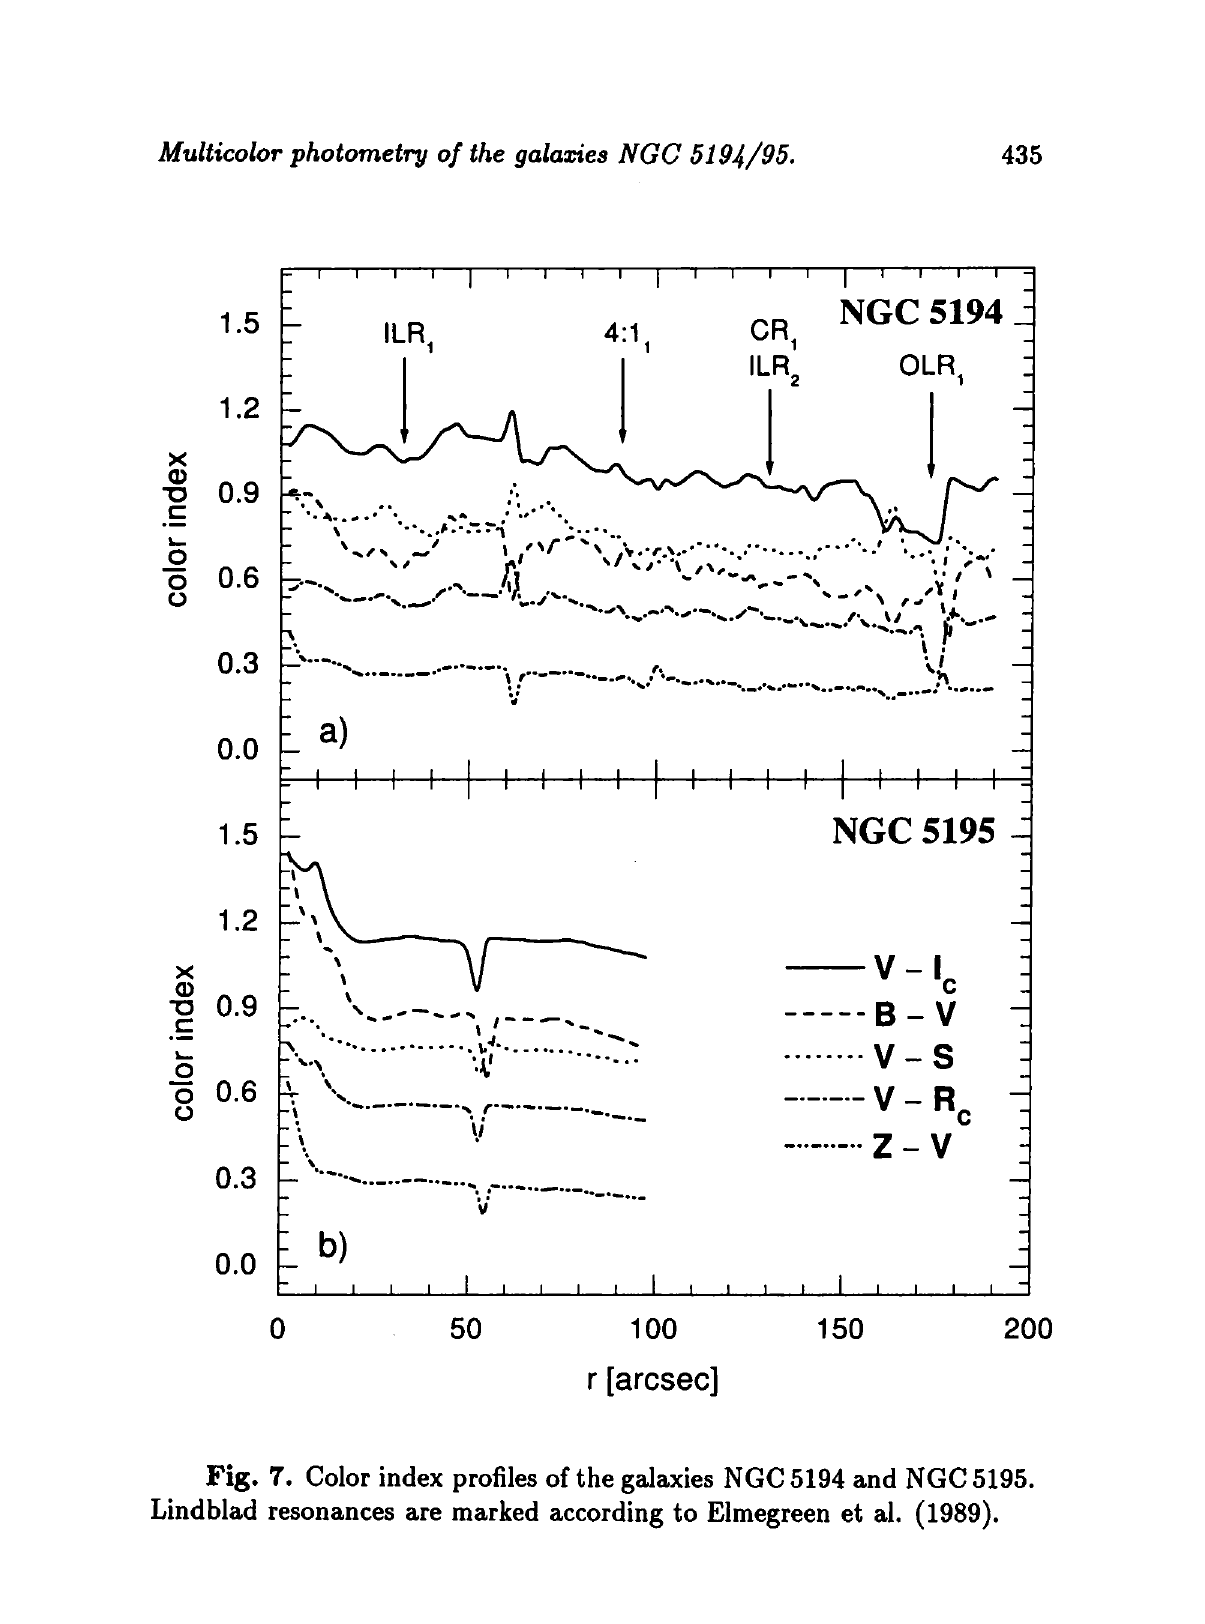
Fig. 7. Color index profiles of the galaxies NGC5194 and NGC5195. Lindblad resonances are marked according to Elmegreen et al.